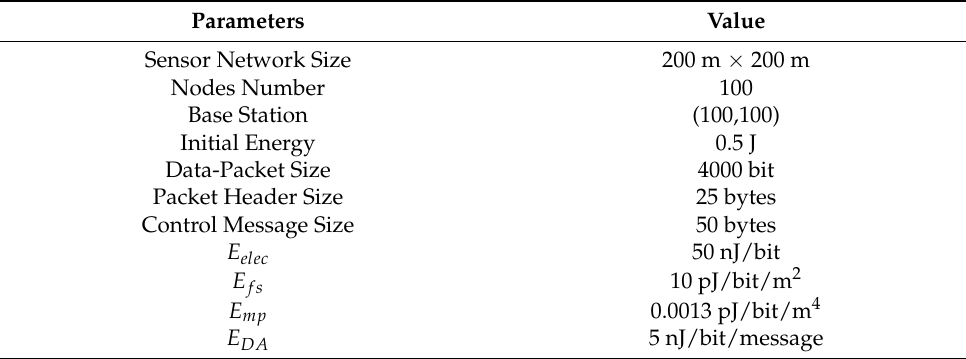
Figure 2. Node distribution of the WSNs. Table 3. Simulation